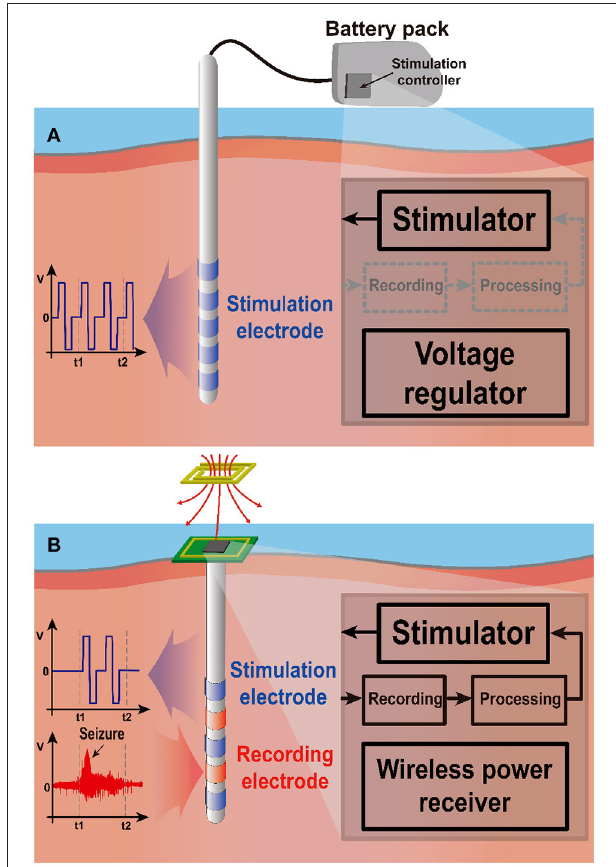
FIGURE 6 | Two stimulation schemes: open-loop and closed-loop stimulation. (A) The open-loop system stimulates continuously regardless of the neural activity, requiring large battery pack outside of the stimulation site due to high power consumption. (B) The closed-loop system stimulates only when needed, leading to low power consumption. Wireless power transmission can power the implanted stimulation